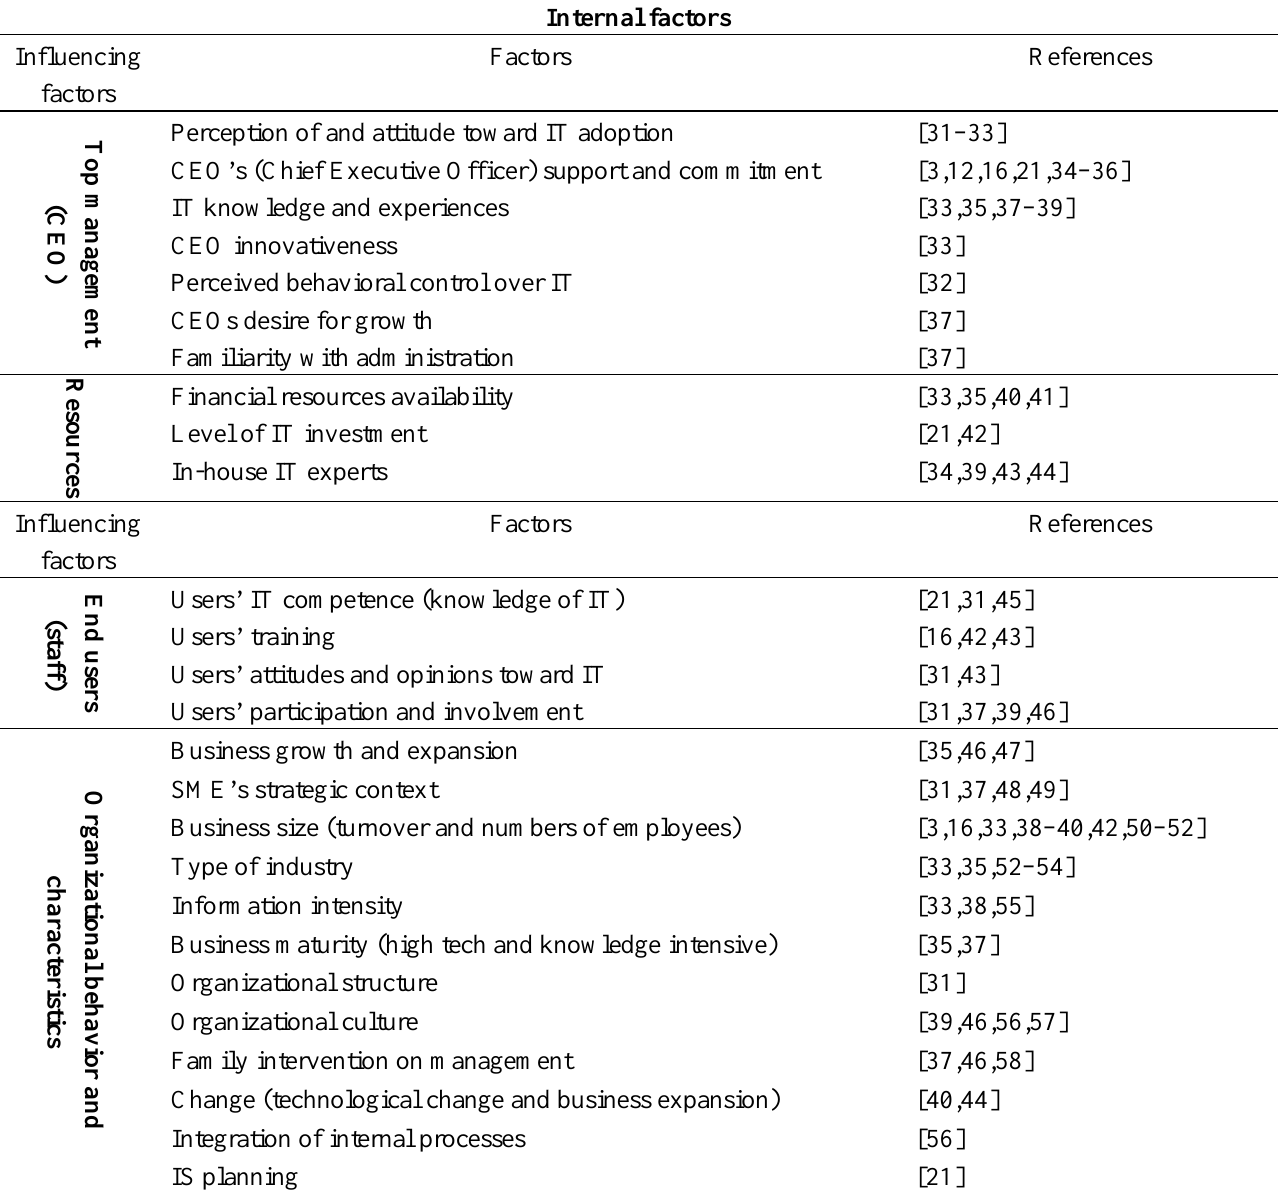
Table 1. Factors affecting IT adoption in